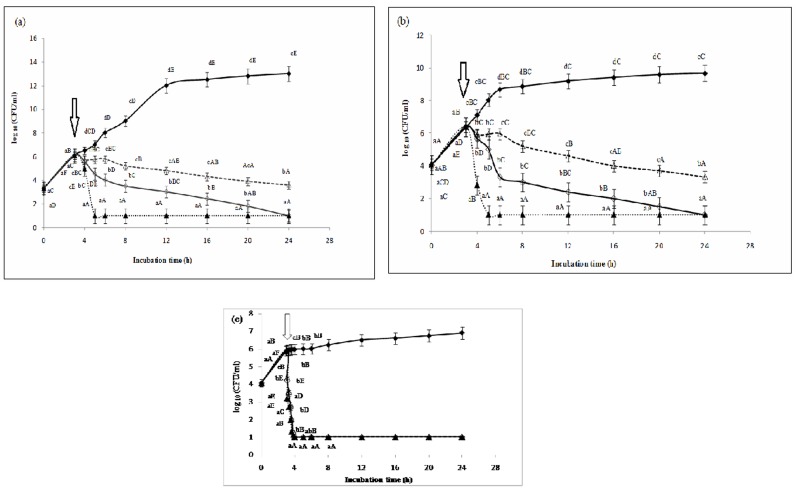
Influence of the dose of IP6 on the growth of L. monocytogenes ATCC 19117 (a), S. aureus ATCC 6538(b) and S. Typhimurium ATCC 14028 (c) in vitro using a linear model (ANOVA).